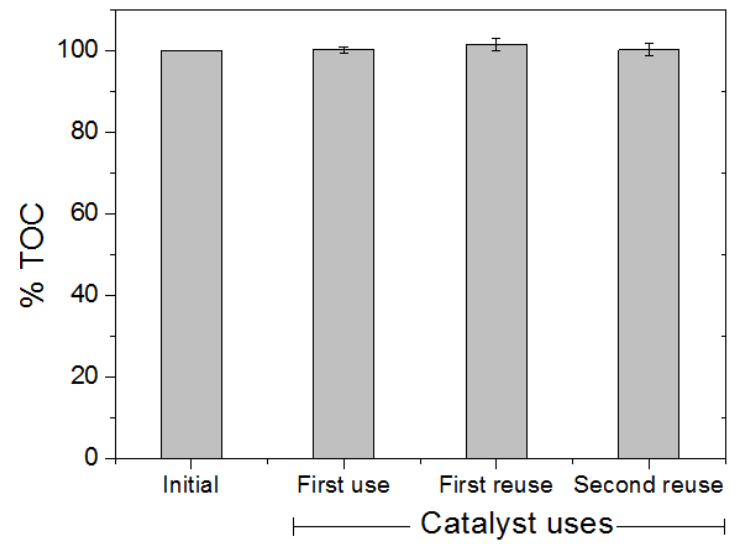
Figure 18. TOC percentage at the end of each catalyst reuse cycle.